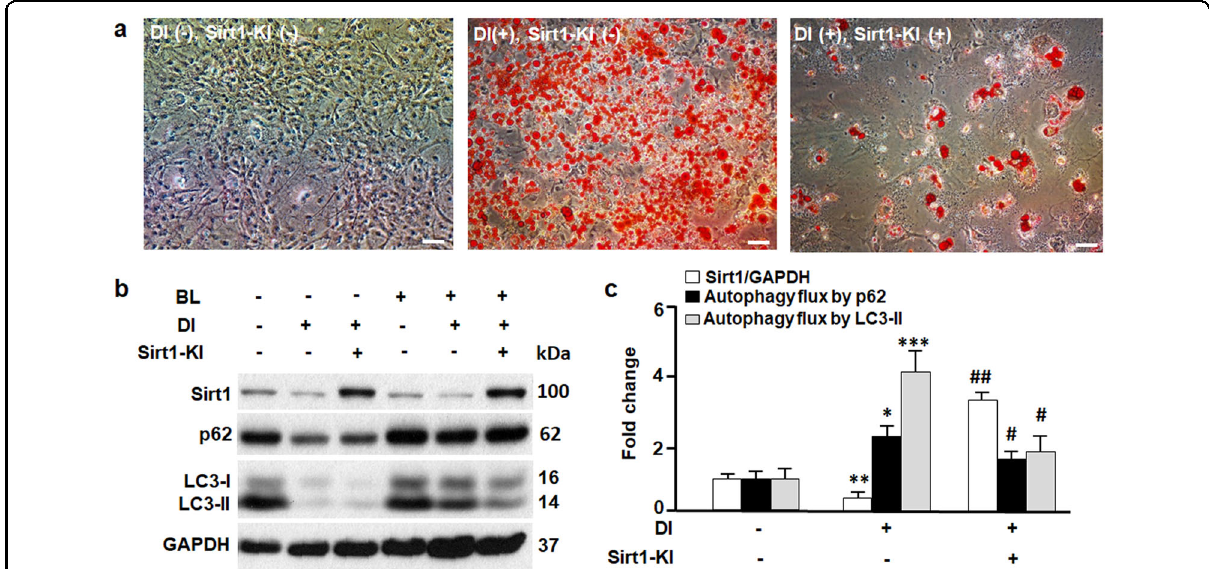
Fig. 2 The effects of gain of Sirt1 on autophagy and adipogenesis. a Oil red O staining of 3T3L1 cells on day 12, in the absence ( − ) or presence ( + ) of differentiation inducer (DI) and Sirt1 knock-in or overexpression (Sirt1-KI). Scale bar, 50 µm. b Western blotting analysis of Sirt1, p62, and LC3 proteins. GAPDH was probed as a loading control. Autophagy inhibitors ba fi lomycin A1 at 0.1 μ M and leupeptin at 10 μ g/ml (BL) were used to treat the cells and measure the turnover of autophagic substrates p62 and LC3-II (i.e., autophagy fl ux activities). c Densitometric analyses of Sirt1 and autophagy fl ux. Comparing DI( − )Sirt1-KI( − ) with DI( + )Sirt1-KI( − ): * p < 0.05; ** p < 0.01; *** p < 0.001. Comparing DI( + )Sirt1-KI( − ) with DI( + )Sirt1-KI( + ): # p < 0.05; ## p < 0.01. n =